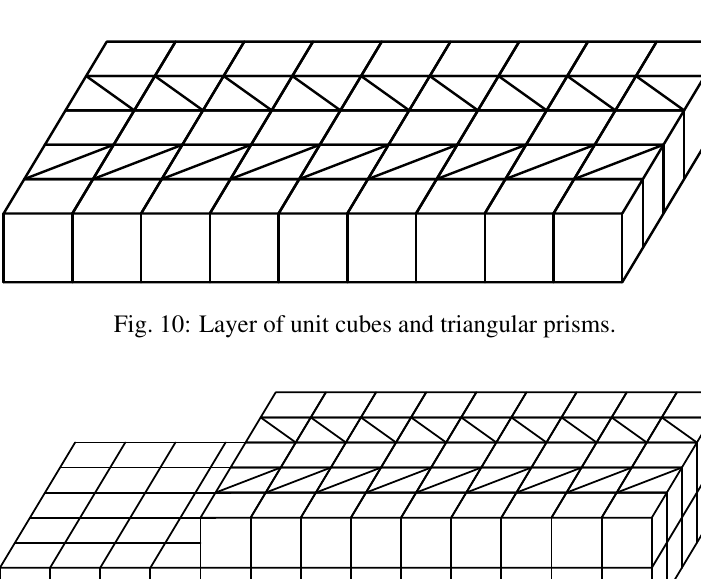
Fig. 9: Building block for an non-periodic tiling.